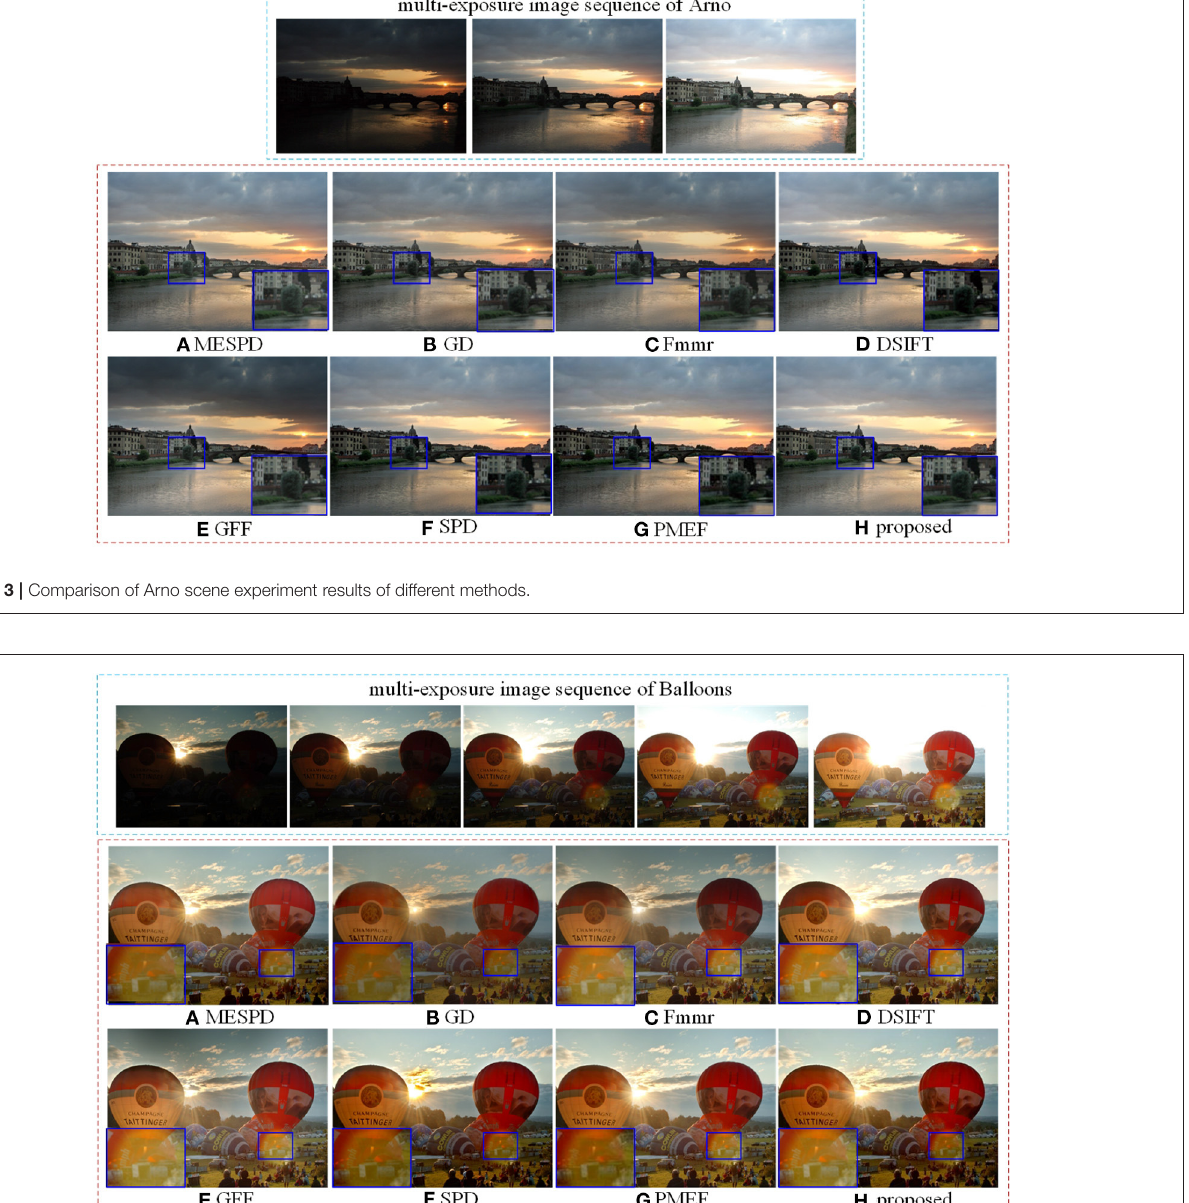
means the details of the overexposed image areas can be well captured. But the overall scene is dark, resulting in the detail loss of underexposed image areas. The image fused by GFF has a slight halo on the edge of the hot air balloon. Additionally, part of the sky is dark and the image color is slightly distorted. The sunset area of the image fused by SPD is abnormal. In addition, the image color is seriously distorted, which seriously affects the overall performance of the fused image. When comparing the enlarged details, MESPD, GD, Fmmr, SPD, and PMEF have low brightness, poor visibility and serious loss of details in this